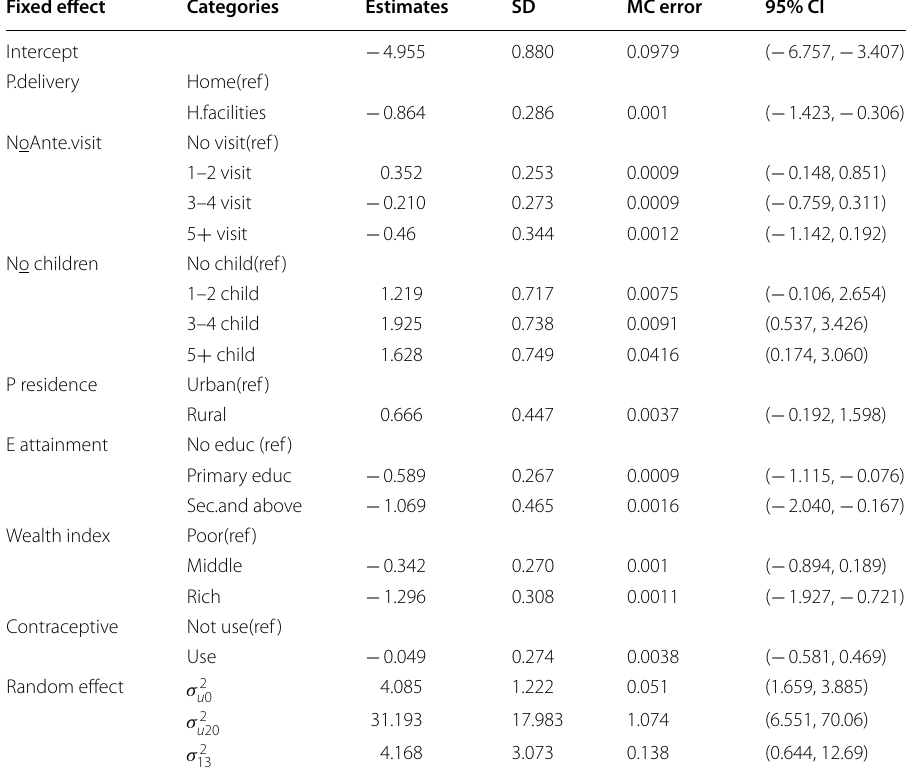
Table 3 Bayesian Estimates for Random coefficient